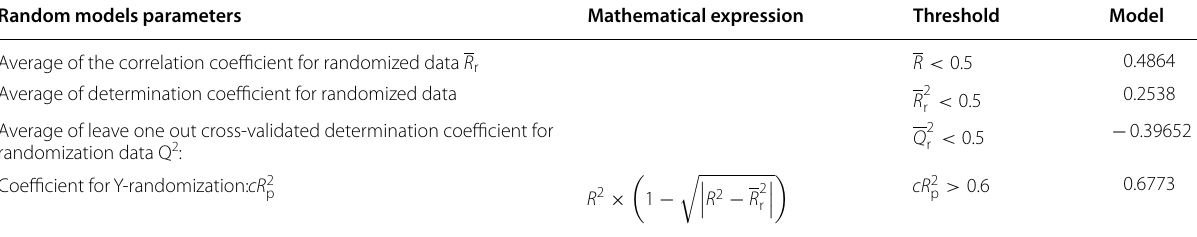
Table 7 Random models parameters Random models